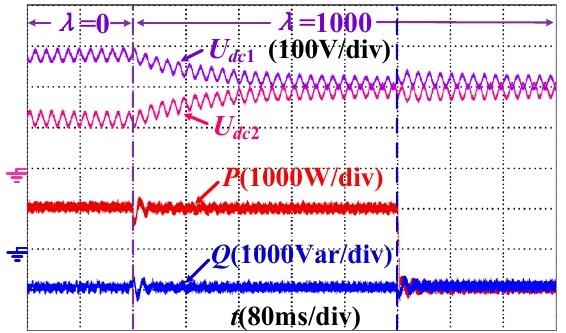
Figure 17. Experimental dc-link capacitor voltage waveforms of proposed MPDPC with reference active power steps from 1000 W to − 1000 W and a different weighting coefficient. Table 3. Comparison of current THD and unbalance.